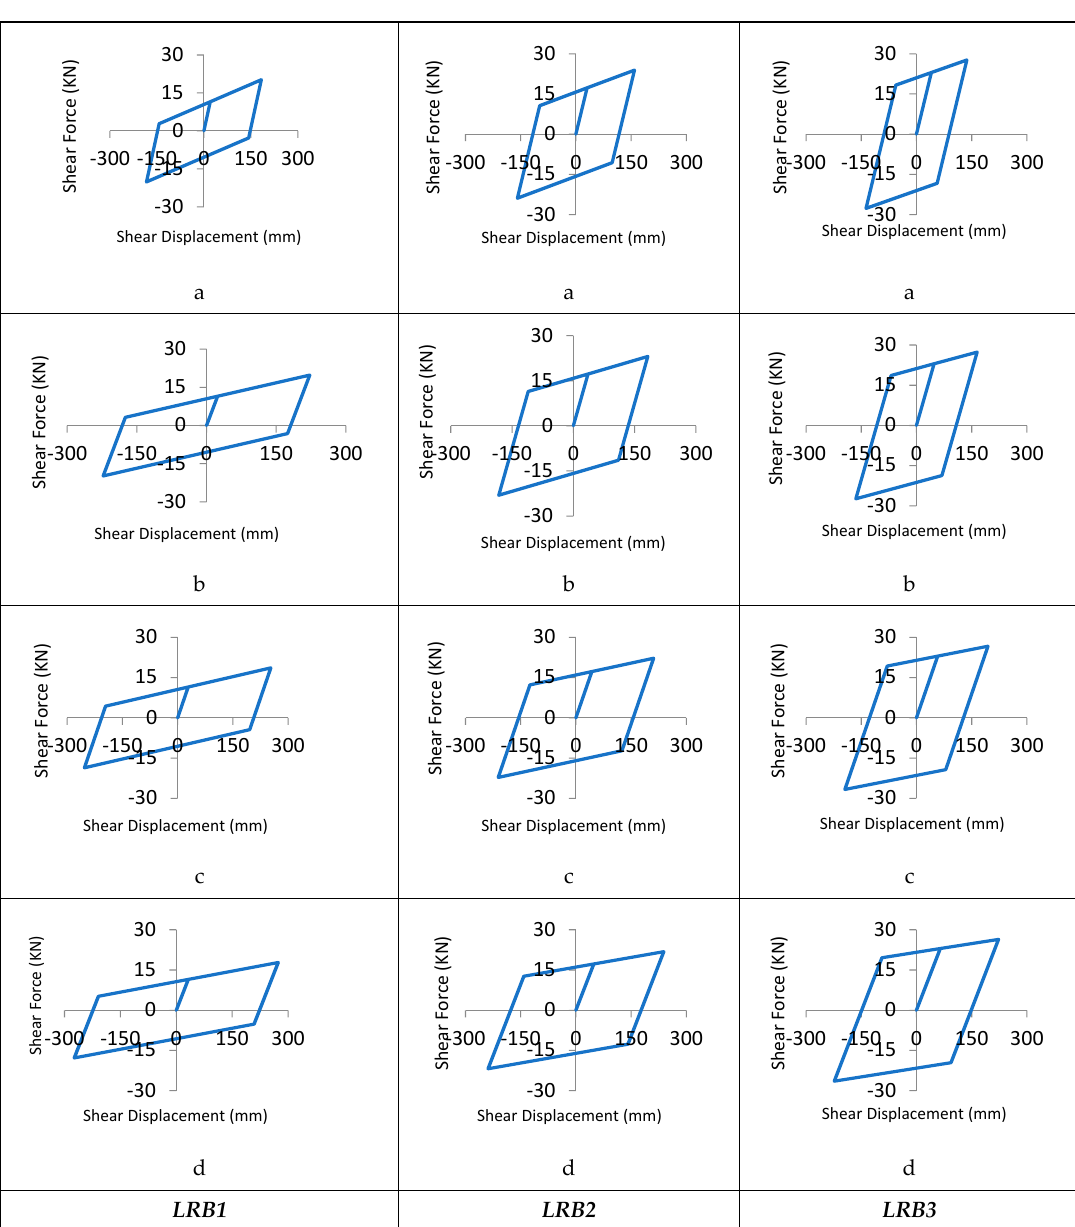
Figure 4. Hysteresis loop of LRB system for varying isolation periods.